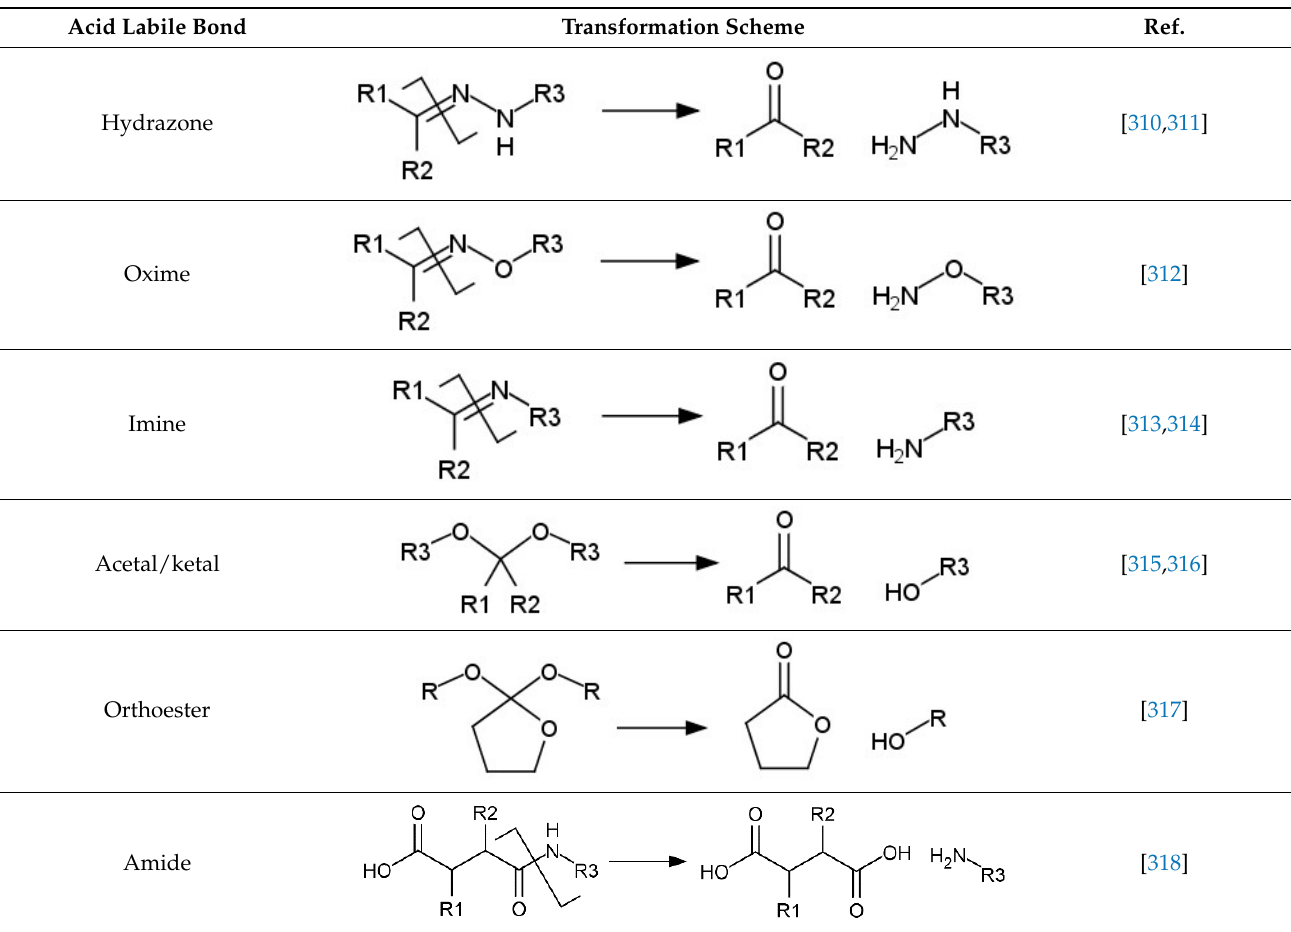
Table 1. List of pH-labile bonds. Transformation Scheme